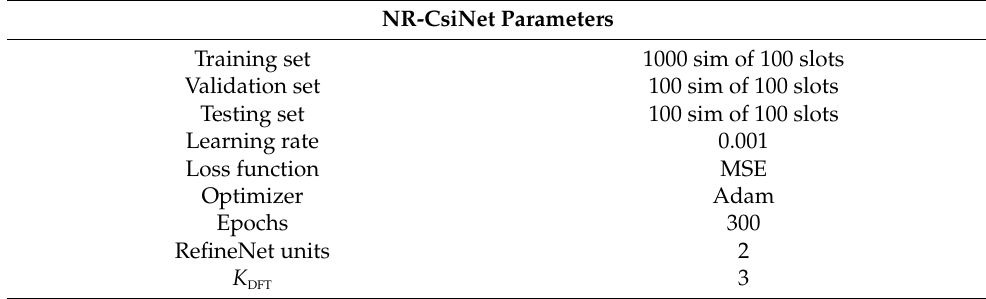
Table 2. NR-CsiNet model parameters [32]. NR-CsiNet Parameters Training